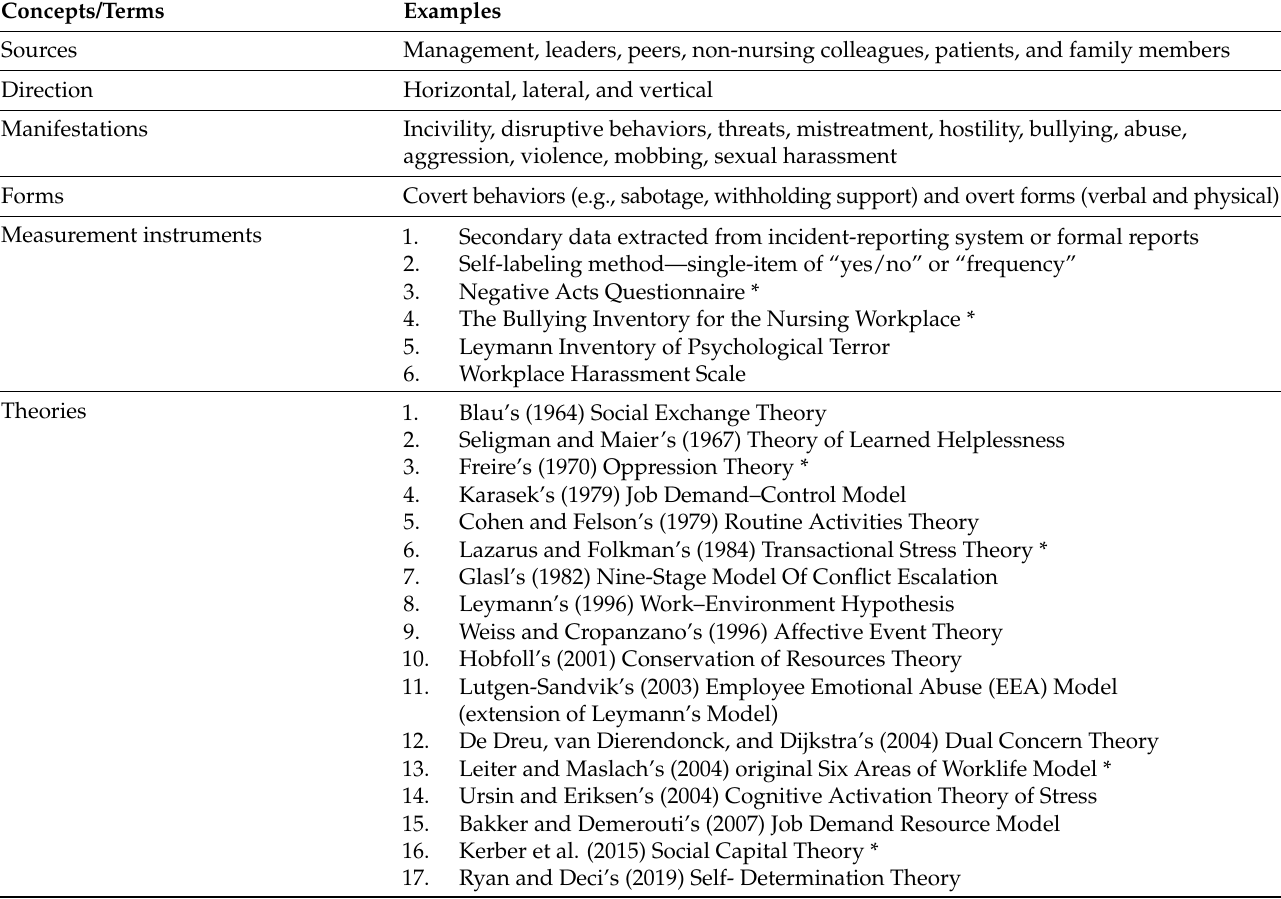
Table 6. Summary of concepts, terms, measurement tools, and theories for workplace bullying in nursing and non-healthcare